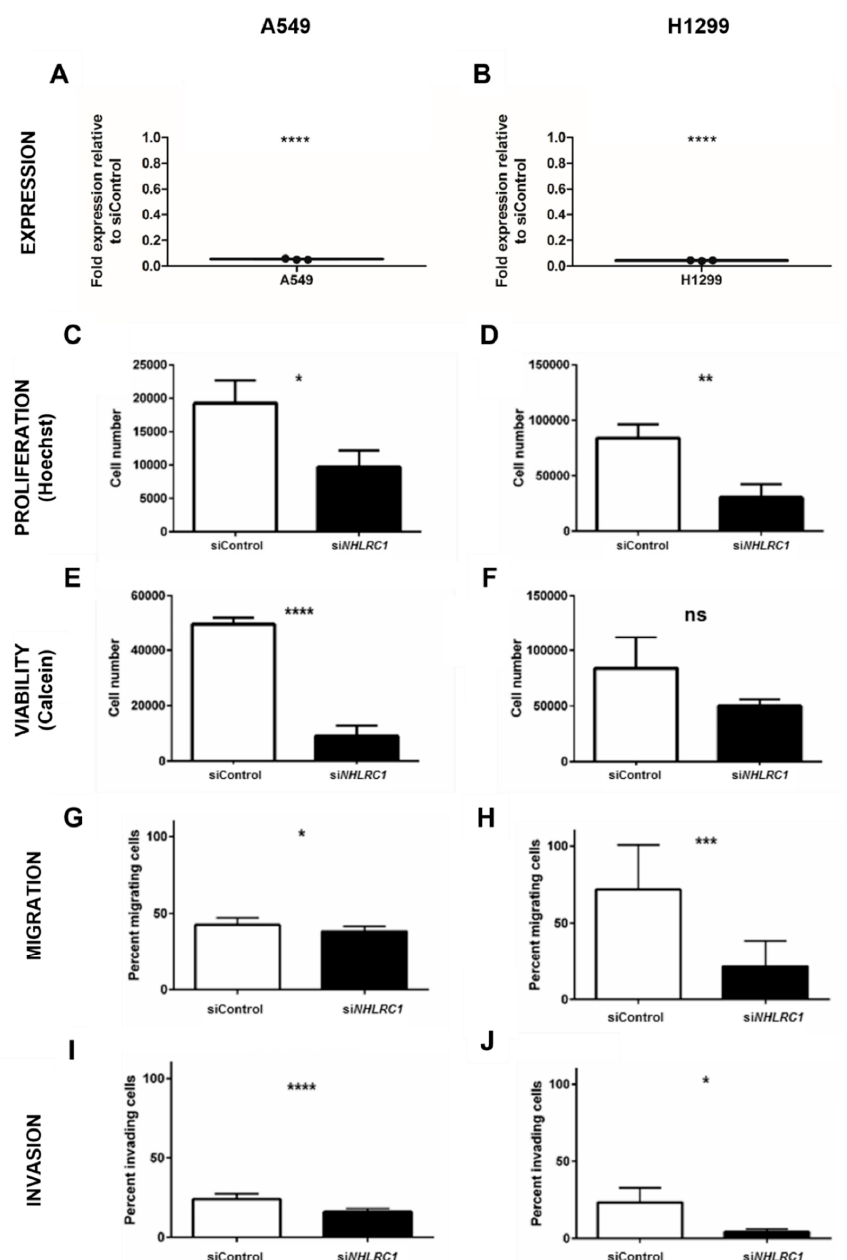
Figure 4. Proliferation–viability assay and glucose uptake in NHLRC1 knock-down lung cancer cells. ( A , B ) Real-time PCR to confirm NHLRC1 knock-down in A549 ( A ) and H1299 ( B ) relative to siRNA control-treated cells. NHLRC1 : NHL repeat containing 1. siNHLRC1: NHLRC1 KD. siControl: Control siRNA treated cells. ( C , D ) Proliferation measured by Hoechst staining of A549 ( C ) and H1299 ( D ) in NHLRC1 knock-down cells after 96 h after NHLRC1 KD. ( E,F ) Viability of A549 ( E ) and H1299 ( F ) measured by Calcein-AM to Calcein turnover 96 h after NHLRC1 KD. ( G , H ) Transwell migration–invasion assays of NHLRC1 KD cells using FBS as a chemoattractant: 24 h migration of A549 cells through 0.8 µM pores ( G ) and 24 h migration of A549 cells through 0.8 µM pores ( H ). ( I , J ) 24 h basement membrane invasion of A549 ( I ) and H1299 ( J ) cells. Two-tailed t -test p -values, *: p < 0.05, **: p < 0.01, ***: p < 0.001, ****: p < 0.0001, ns: not significant.